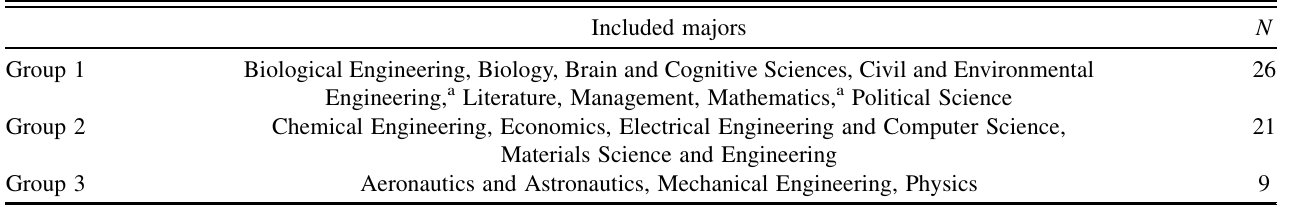
TABLE I. Grouping of majors according to utilization of mechanics. N is the number of participants from each group. Included majors N